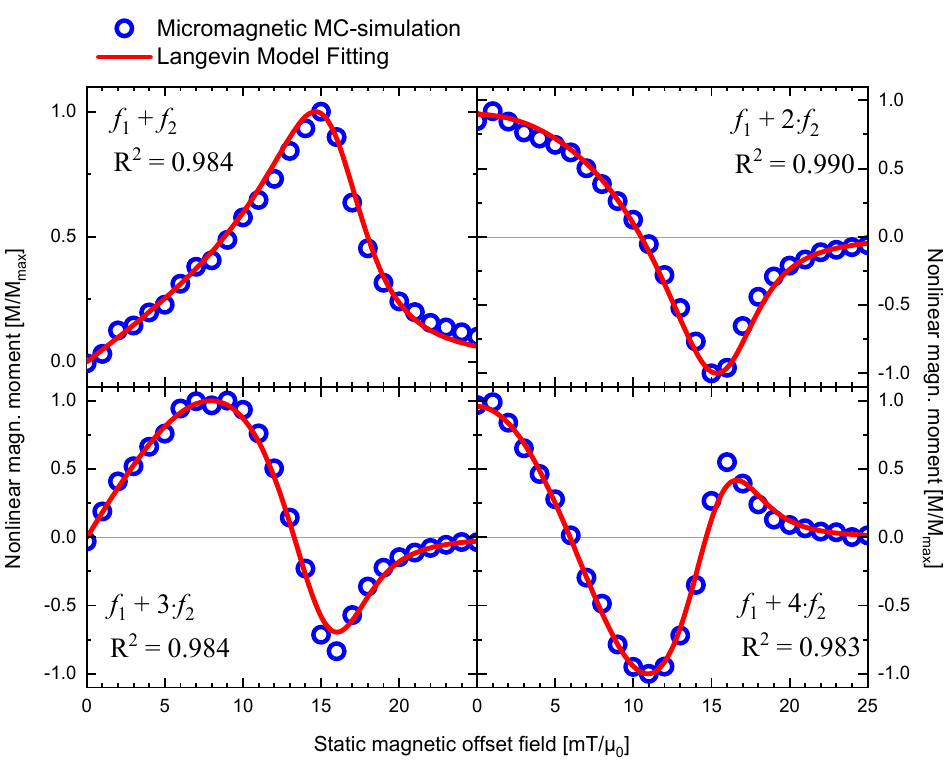
Figure 4. Normalized MNP nonlinear magnetic moment for dual frequency excitation at mixing frequencies f 1 + n · f 2 with n = 1,2,3,4 from micromagnetic MC-simulations fitted with the thermo- dynamic Langevin model with fixed core diameter d C = 7.813 nm.